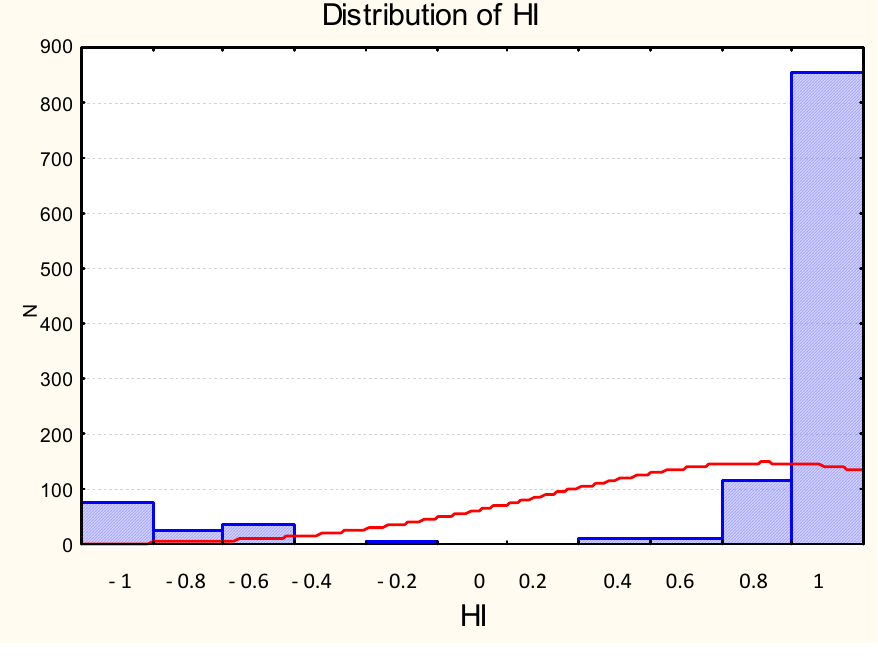
Figure 1. Distribution of HI at 5 years.